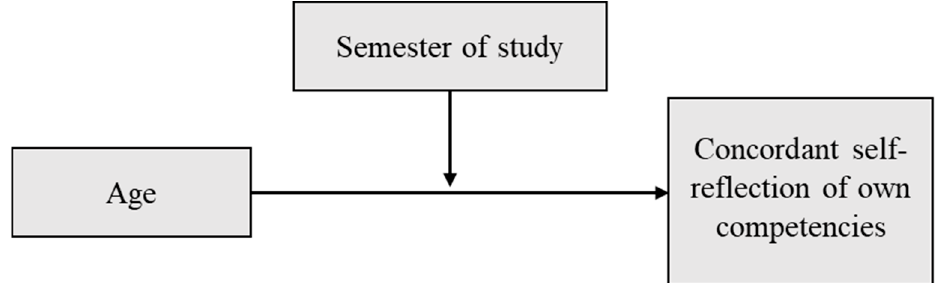
Figure 1. Hypothesized model of the conducted moderated regression analysis.